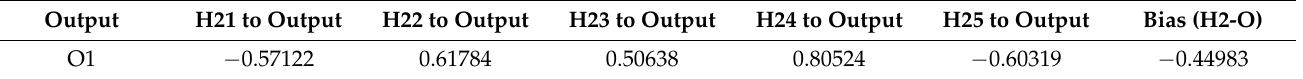
Table 9. Weight and bias between hidden layer and